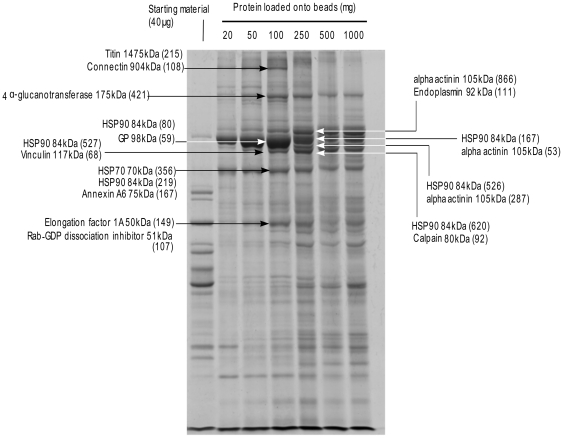
Equalization achieved by extreme bead loading.Prospectrum II beads were exposed to very high levels (up to 1000 mg protein/20 mg beads) of chick skeletal muscle soluble proteins in a final volume of 1.0 mL of 20 mM sodium phosphate buffer, pH 7.0. After 2 h, the beads were washed exhaustively (8 successive washes in the same buffer) and samples were analyzed by 1D SDS-PAGE as described in the legend to Figure 1. Bands were excised, digested with trypsin and analyzed by LC-MS/MS and selected identified proteins are highlighted on the gel.